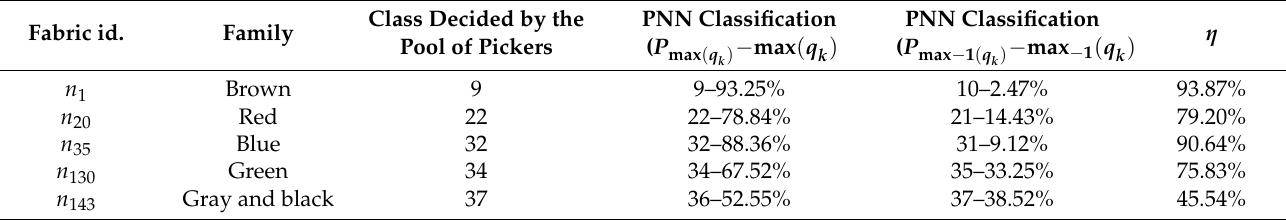
Table 2. PNN classification.